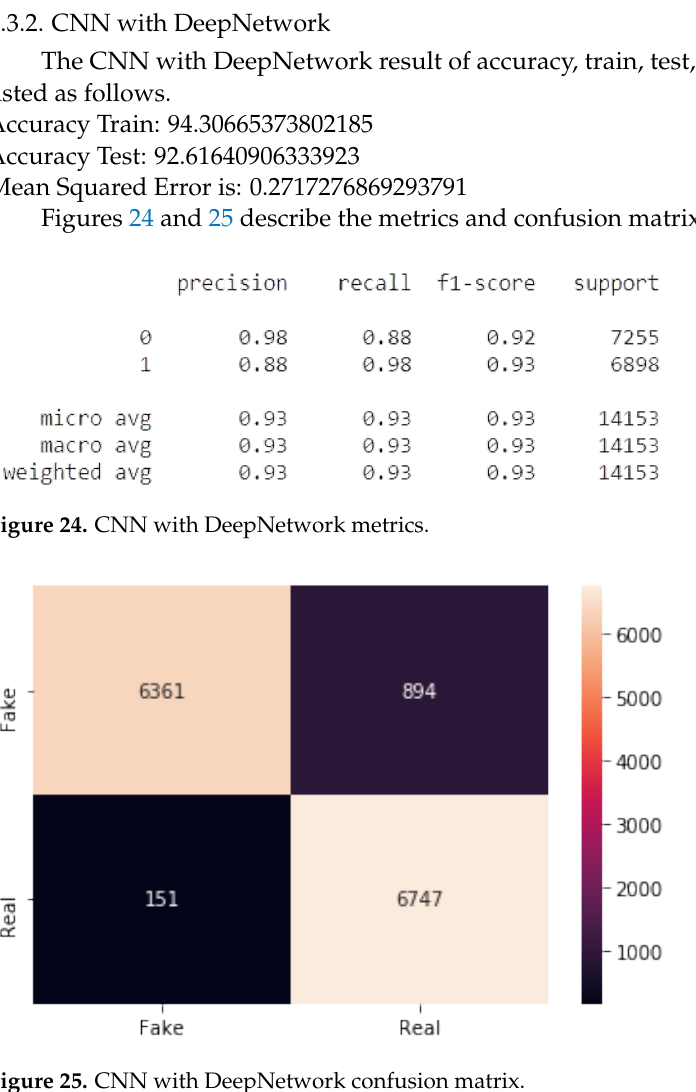
Figure 25. CNN with DeepNetwork confusion matrix.